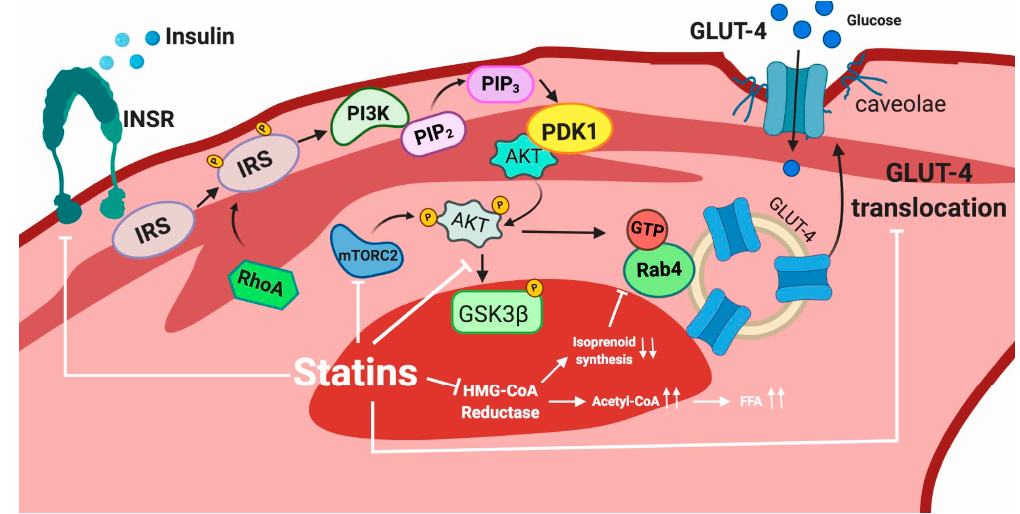
Figure 5. Intracellular actions of statins in muscle cells. White lines indicate the mechanisms affected by statins.